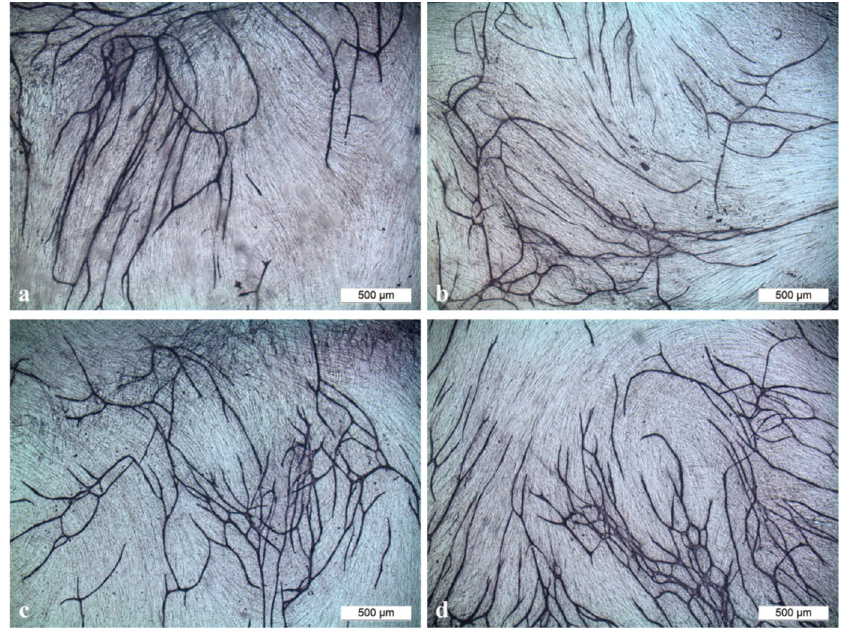
Figure 9. Tubule formation in the angiogenesis assay performed with ( a ) titanium implant; ( b ) titanium implant coated with PCL (poly- ε -caprolactone); ( c ) titanium implant coated with PCL functionalized with VEGF (Vascular Endothelial Growth Factor) and ( d ) HMGB1 (High Mobility Group Box 1) in a magnification of 40. Scale bar: 500 µm.